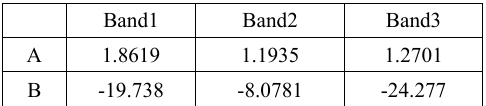
Table 3: Constants calculated for the relation between SPOT-4 and Egyptsat-1 DN’s for each band 4- Finally, the radiometric calibration coefficient for Egyptsat-1 could be deduced in more mathematical details using the following expressions: Given, OffsetDNGainL += SPOTSPOTSPOT From equation (2), ( ) OffsetBDNAGainL ++⋅= SPOTEgyptsatSPOT OffsetGainBDNGainAL +⋅+⋅= SPOTSPOTEgyptsatSPOT The previous equation yields: GainAGain ⋅= SPOTEgyptsat OffsetGainBOffest +⋅= SPOTSPOTEgyptsat